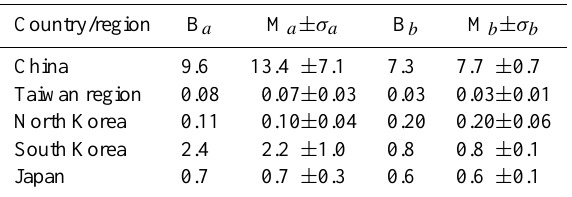
Table 7. HFC-23 emissions (kt/yr) per country/region for the year 2008.